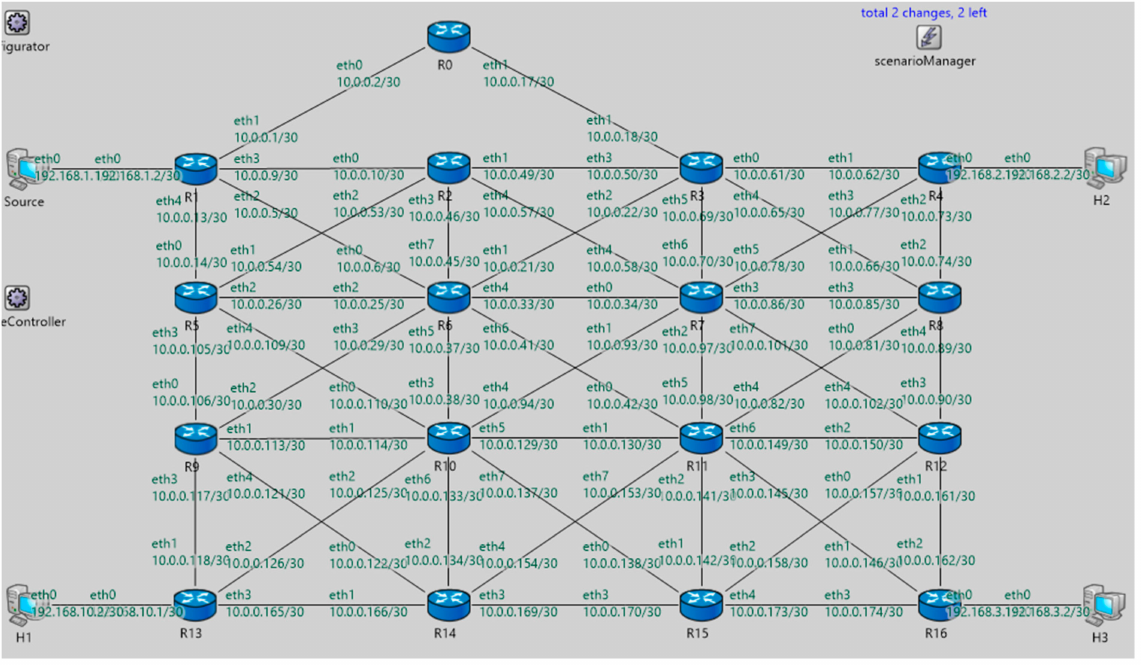
Figure 12. EB-REP simulation